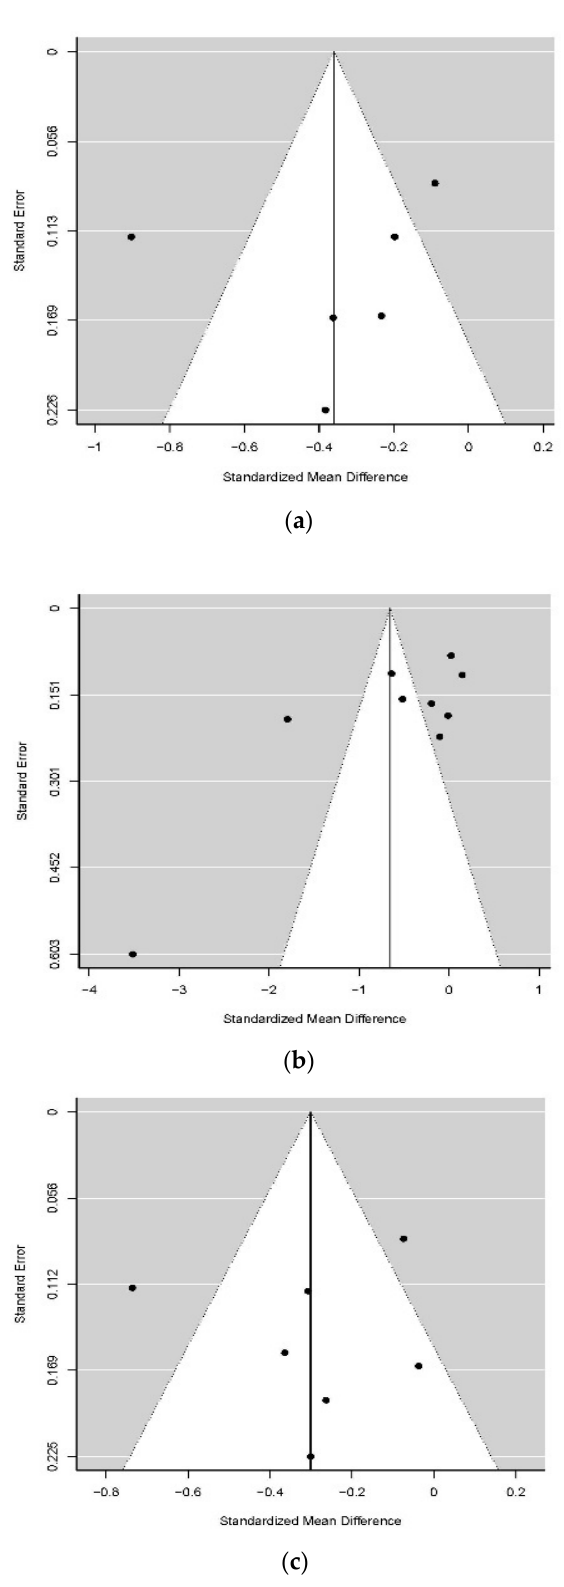
Figure 5. Funnel plot illustrations: ( a ) For randomized controlled trials on reducing stress; ( b ) for randomized controlled trials on reducing anxiety; ( c ) for randomized controlled trials on reducing depression. The fail-safe number N was calculated (N = 79), meaning that 79 studies on depression reduction were needed to nullify the significant effect at p > 0.05.